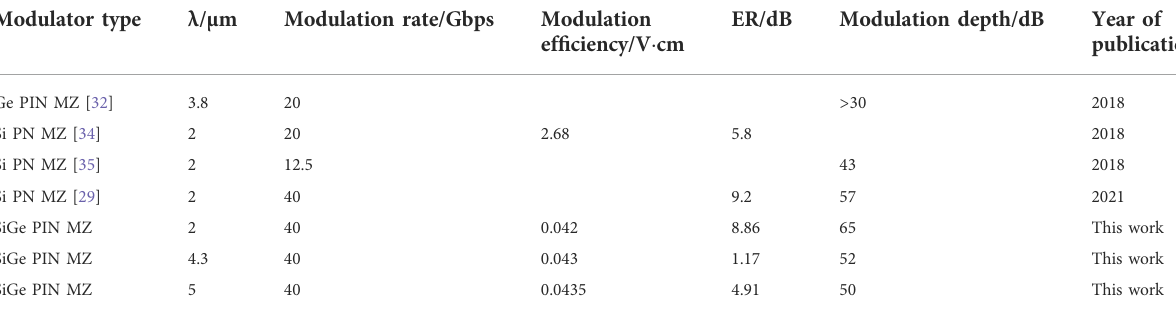
TABLE 2 Performance comparison of different